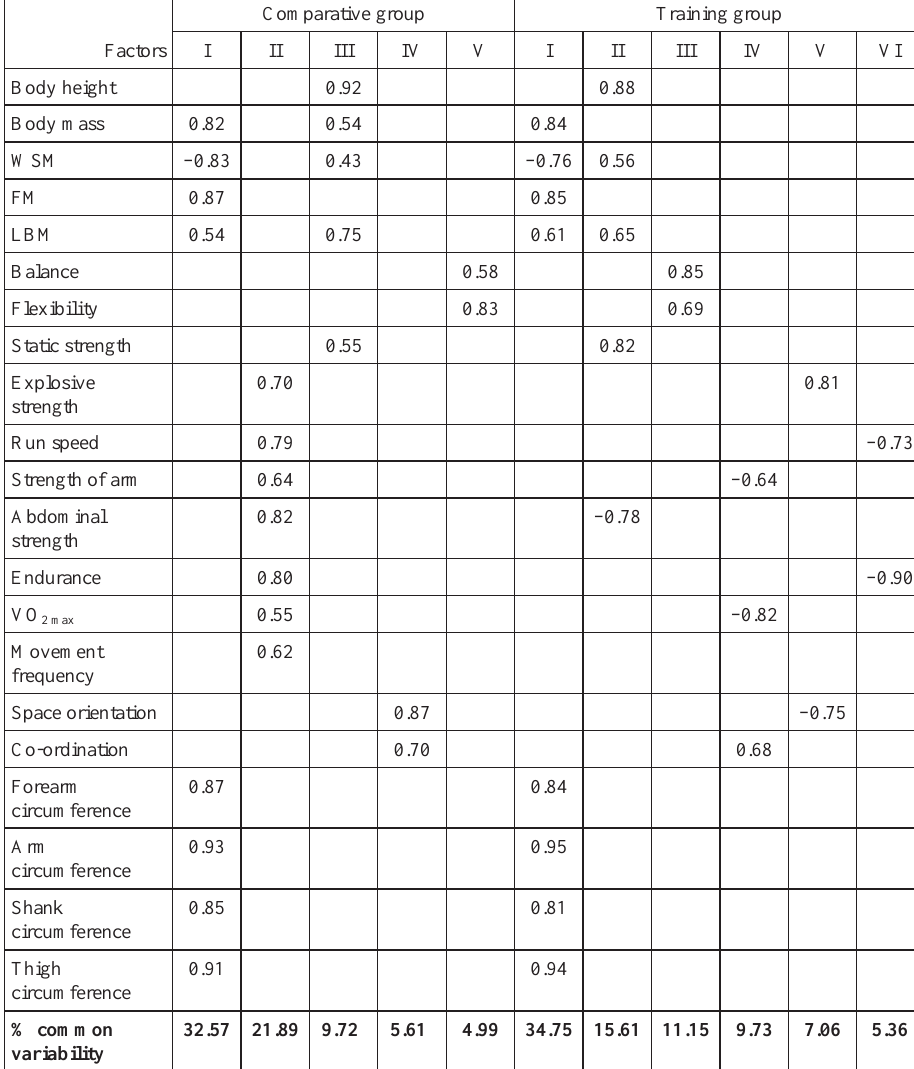
Table 9. The results of the factor analysis in the rese- arch